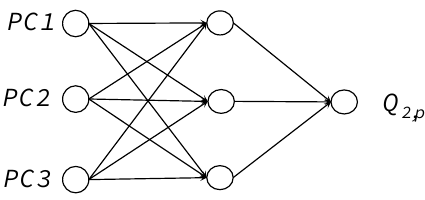
Figure 3. Architecture of the chosen network, with three input nodes, three hidden nodes and 1 output